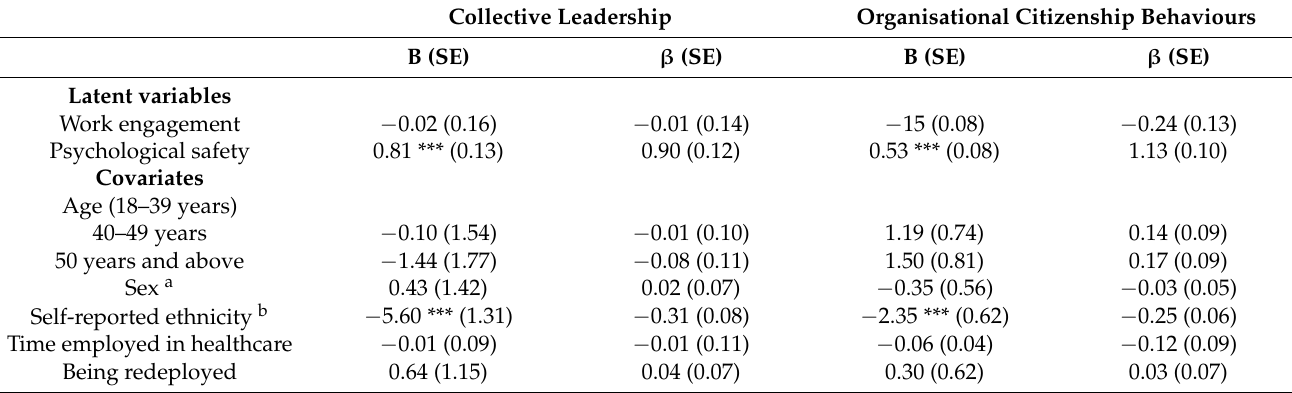
Table 2. SEM model of work engagement, psychological safety, collective leadership, and organisational citizenship